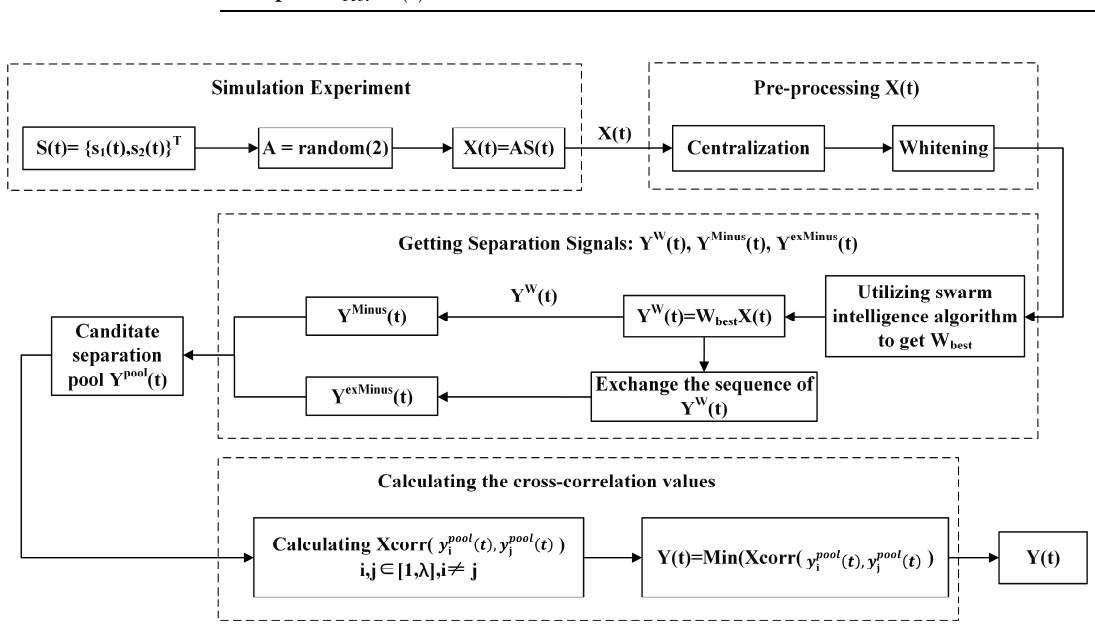
Figure 5. SI-XBSS flow chart.